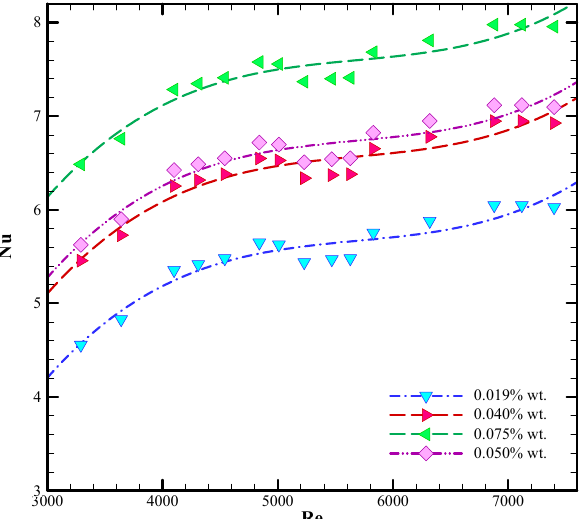
Figure 13. Variation of average Nusselt number for novel PTSC equipped with a turbulator and filled with nanofluid in different volume fractions of nanoparticles versus different Reynolds numbers at time 12:30.